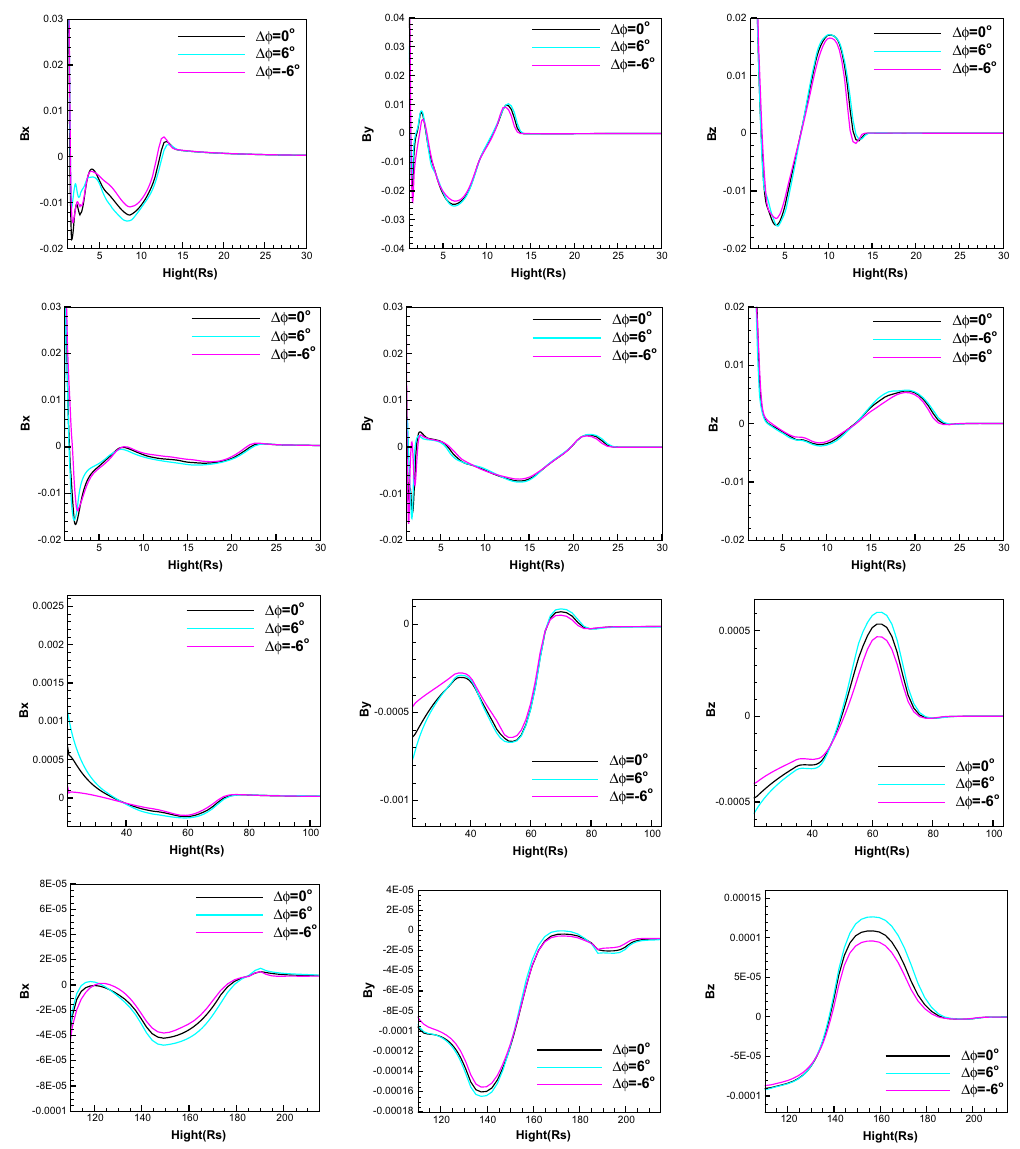
Fig. 13. Evolution of the three components of magnetic fi eld along heliocentric distance with different longitudes at several times. The columns from left to right are B x , B y and B z in GSE coordinates, respectively. The rows (top to bottom) are t = 3, 6, 20 and 60